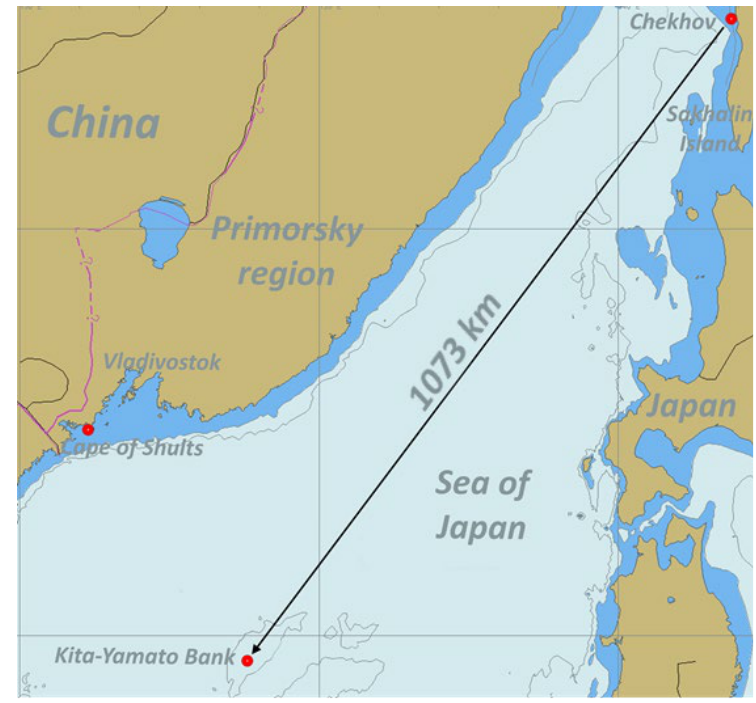
Figure 15. Experiment scheme .